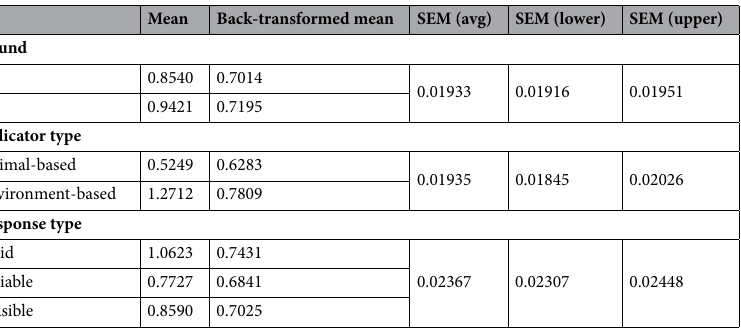
Table 6. Selection of animal- and environment-based indicators across rounds One and Two: GLMM 2 [round, indicator type, response type (fixed effects); respondent (random